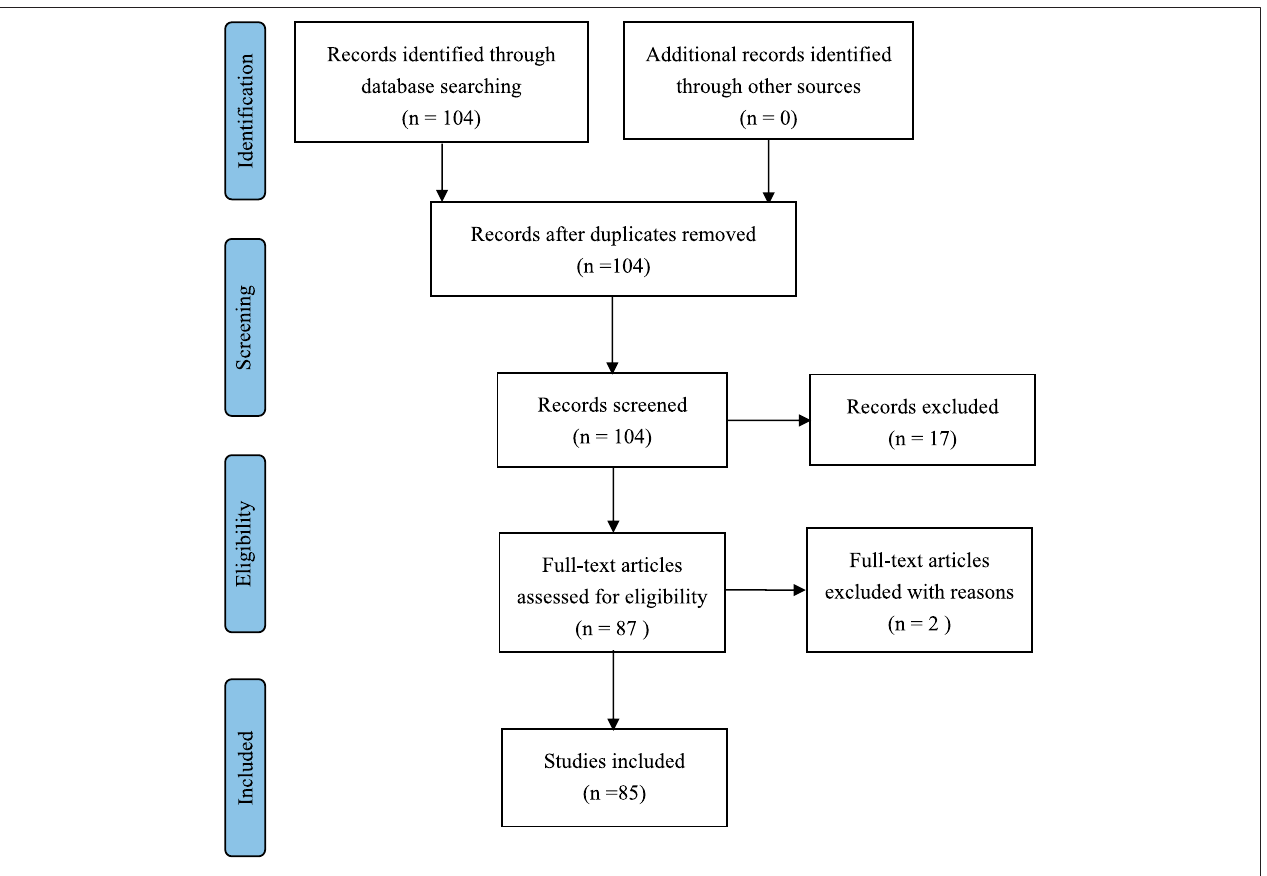
FIGURE 1 | Data extraction process